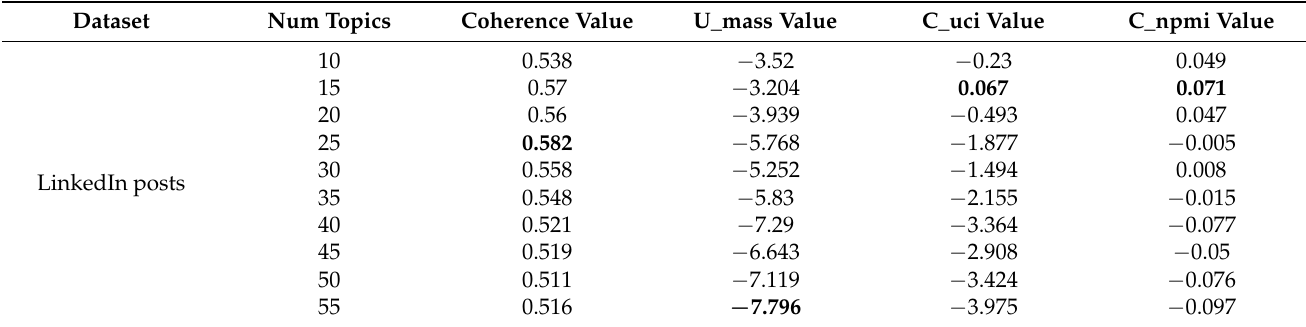
Table 3. Coherence measures for selecting the optimal number of topics.